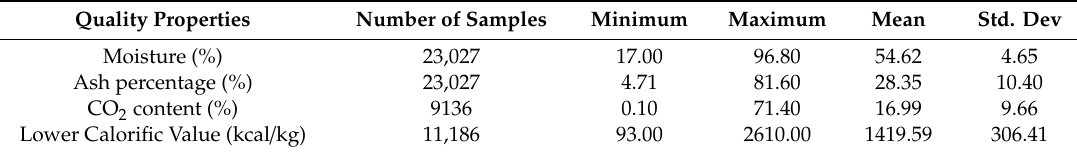
Table 1. Number of samples for each quality property.